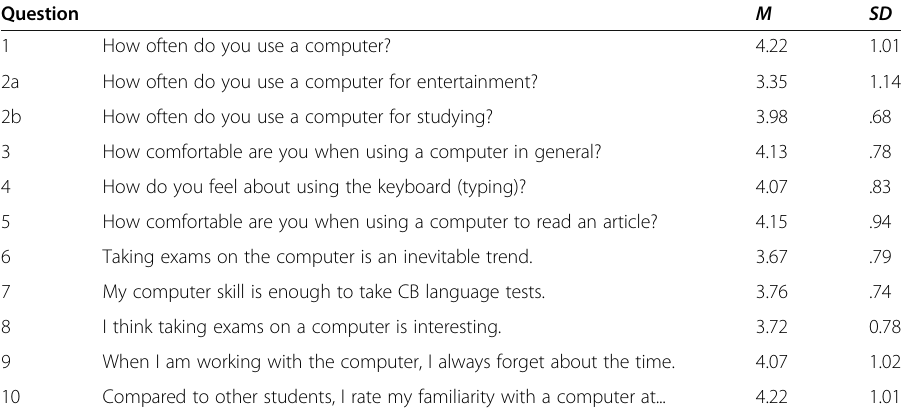
Table 5 Descriptive statistics of the computer familiarity questionnaire Question